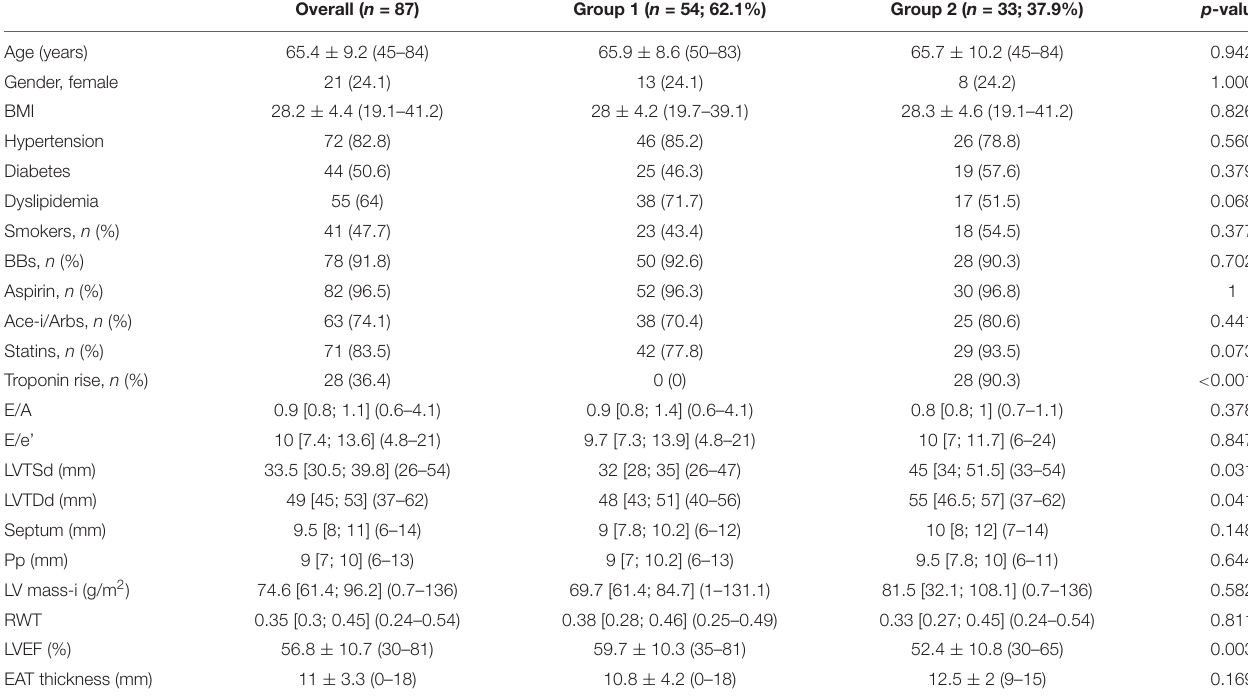
TABLE 1 | Demographic and clinical data of the study population. Overall ( n = 87) Group 1 ( n = 54; 62.1%) Group 2 ( n = 33; 37.9%)